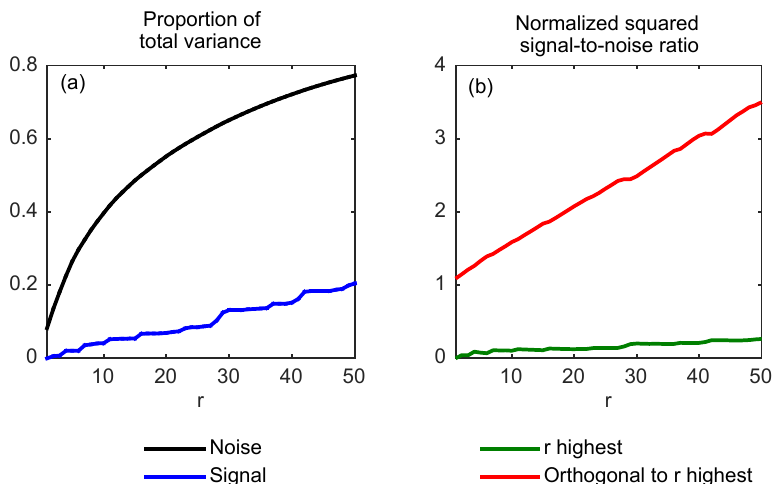
Figure 1. (a) Proportion of the total variance of the projected anthropogenic signal V (cid:48) r x 1 (thick blue line) and of the projected noise V (cid:48) r ν (thick black line) as functions of r ; uniform increase r/n (light black line). (b) Signal-to-noise ratio of the projected data when using the projection subspace V r consisting of the r leading eigenvectors (thick green line) and when using the orthogonal subspace V ⊥ r (thick red line) as functions of r . Both values are normalized to the signal-to-noise ratio of the full